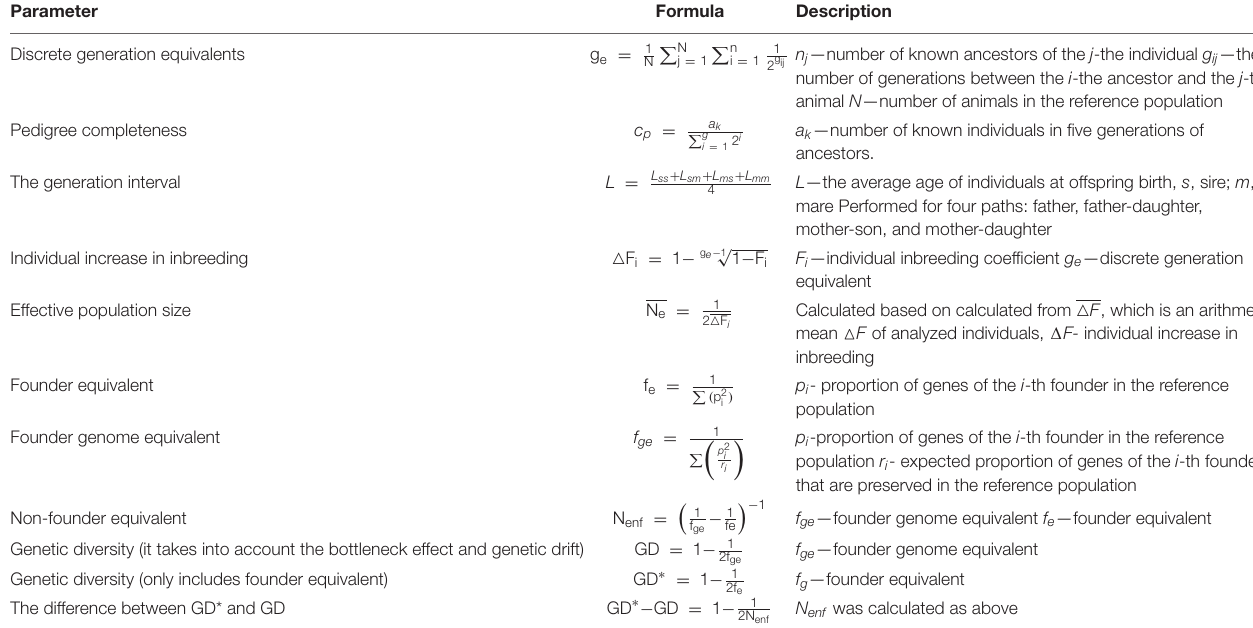
TABLE 2 | The statistical measurements used for the population